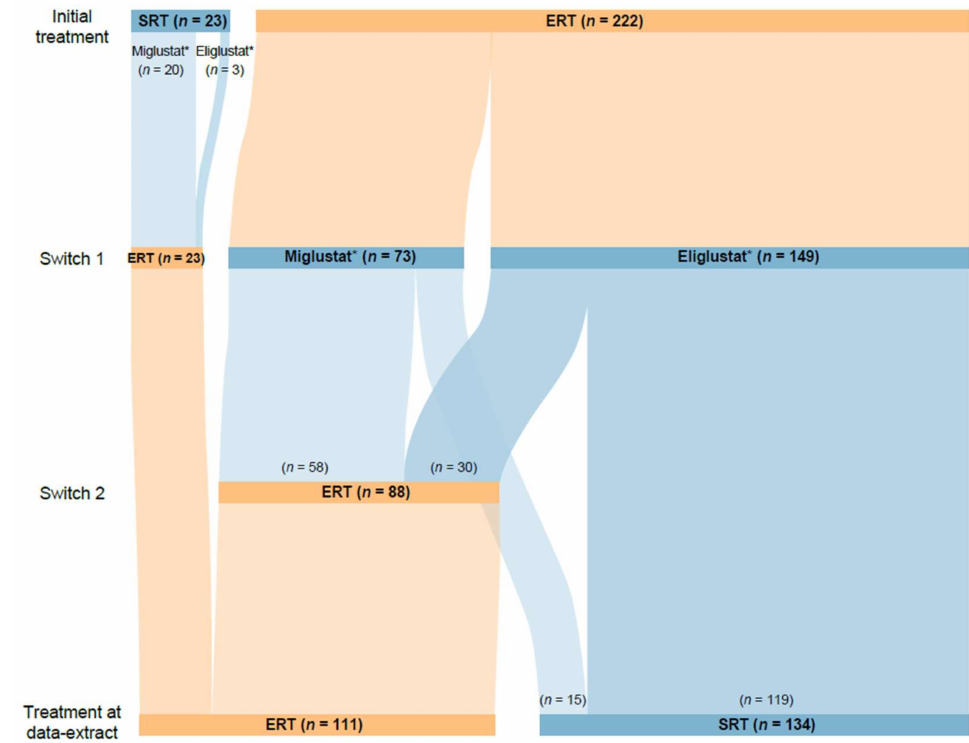
Figure 1. Patient flow. Abbreviations: ERT, enzyme replacement therapy; SRT, substrate reduction therapy. * Treatments indicate the first agent received in each treatment period. Subsequent within- class switches were not